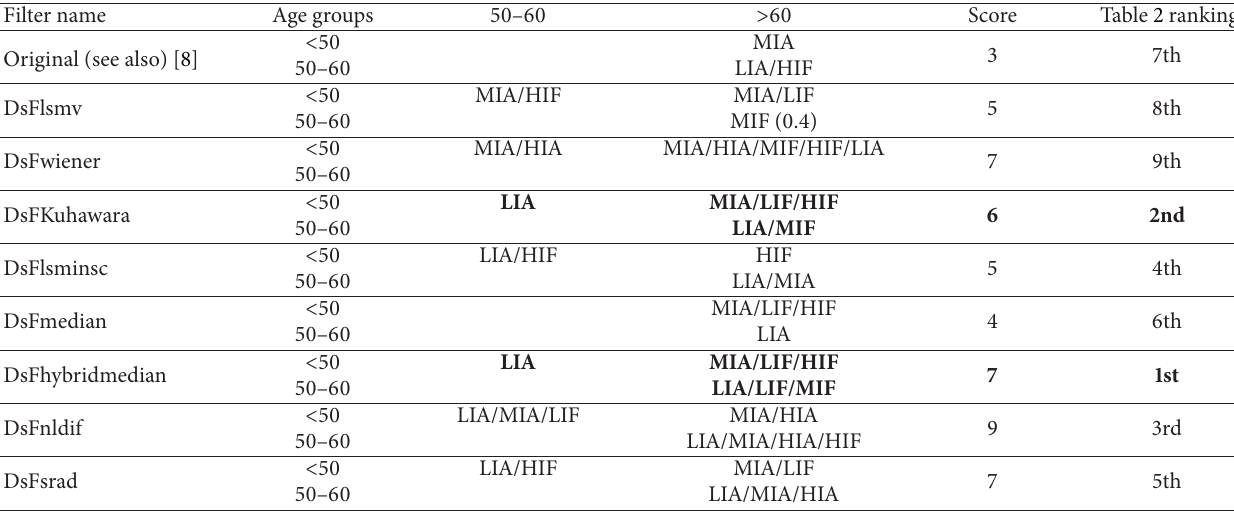
Table 3: Statistical analysis between the low, medium and high AM-FM features extracted from the IMC for the automated segmentation measurements for the three different age groups, below 50 ( < 50), between 50 and 60 (50–60), and above 60 ( > 60) years old based on the Mann-Whitney rank sum test for all despeckle filtering techniques. Only the features that exhibited statistical significant differences at P < 0.05 are